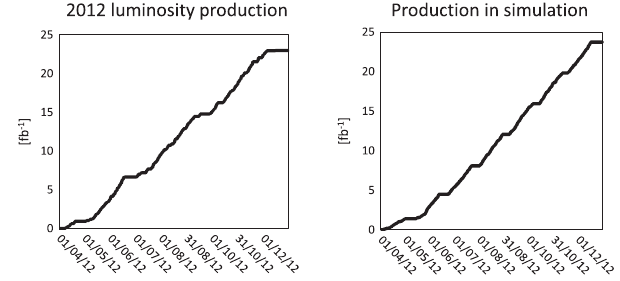
FIG. 11. Actual LHC integrated luminosity production during 2012 compared to production in one model simulation.